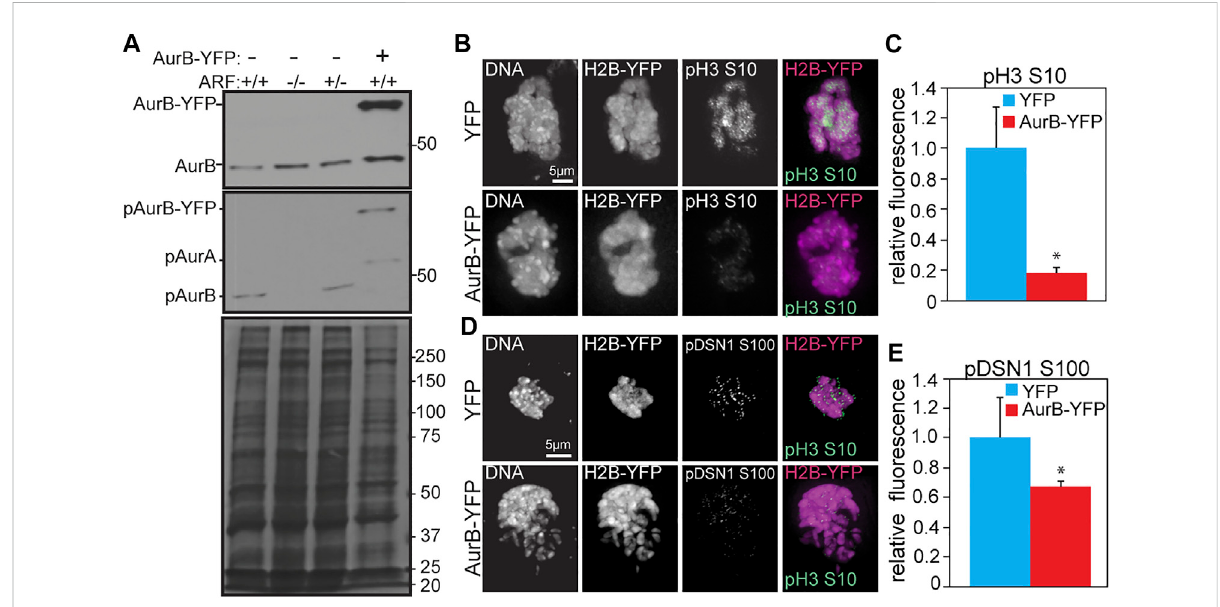
FIGURE 2 Expression of Aurora B-YFP reduces Aurora B-dependent phosphorylation events in primary MEFs. (A) Immunoblot of MEFs of the indicated genotypes±Aurora B-YFP. ARF − / − MEFs show increased Aurora B and decreased pT237 (active) Aurora B. Coomassie (bottom) shown as loading control. (B – E) Quantitative immuno fl uorescence of pH3 and pDSN1. (B,D) Representative images of ARF +/+ MEFs transfected with YFP or Aurora B-YFP. H2B-YFP was co-transfected and used as a marker of transfected cells. (C,E) Graphs showing quanti fi cation of phosphoantibody